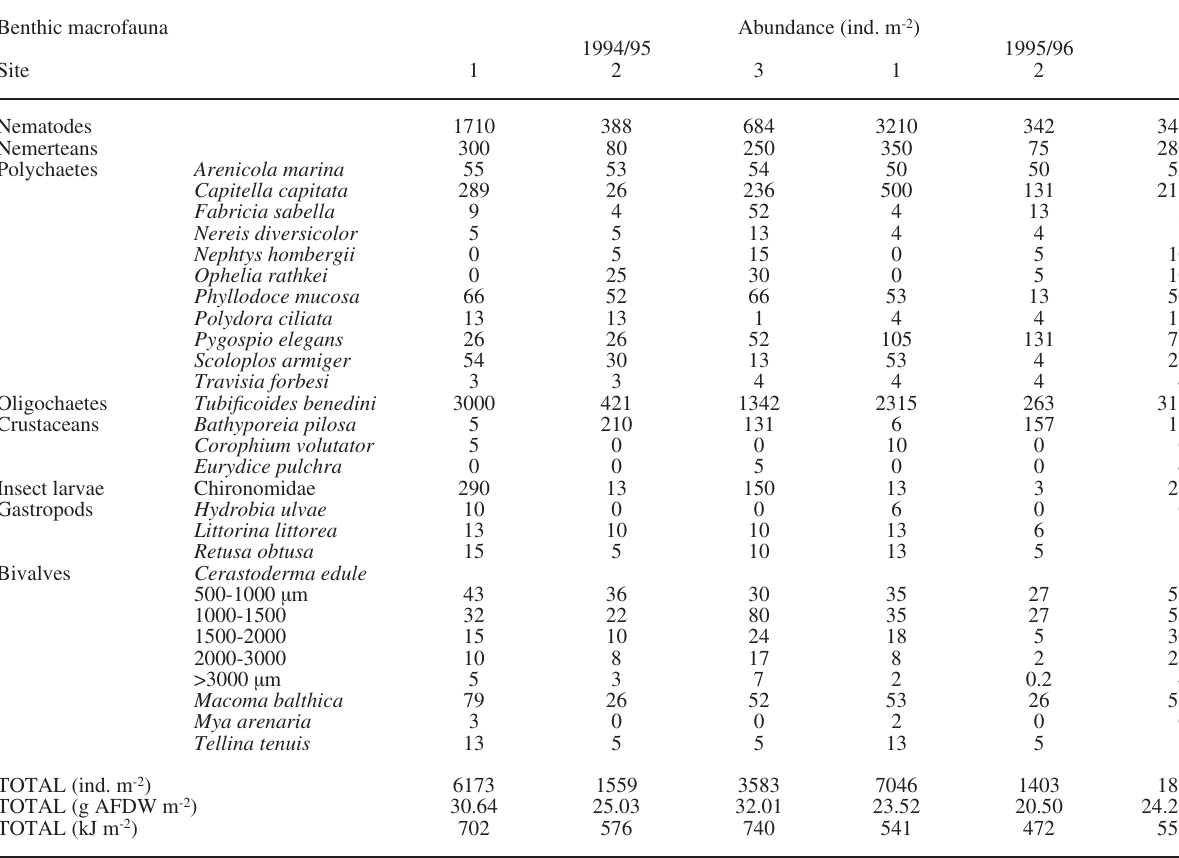
Table 2. – Mean number of individuals per area per annum (ind. m -2 ) in 1994-1995 and 1995-1996 at the three sampled sites at Culbin Sands, Moray Firth, Scotland, and respective biomass (g AFDW m -2 yr -1 and kJ m -2 yr -1 ), outside musselbed areas (not sampled: musselbeds and Semibalanus sp. population on poles left by World War II; species with an abundance <2 ind. m -2 at all sites were not listed). Benthic macrofauna